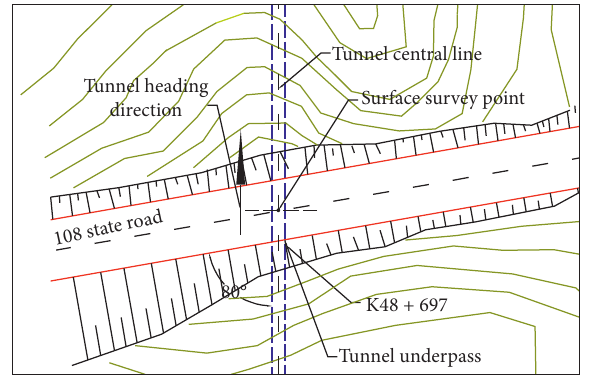
Figure 13: Location of surface survey points. Table 4: Increase the settlement measured on site with the excavation footage.